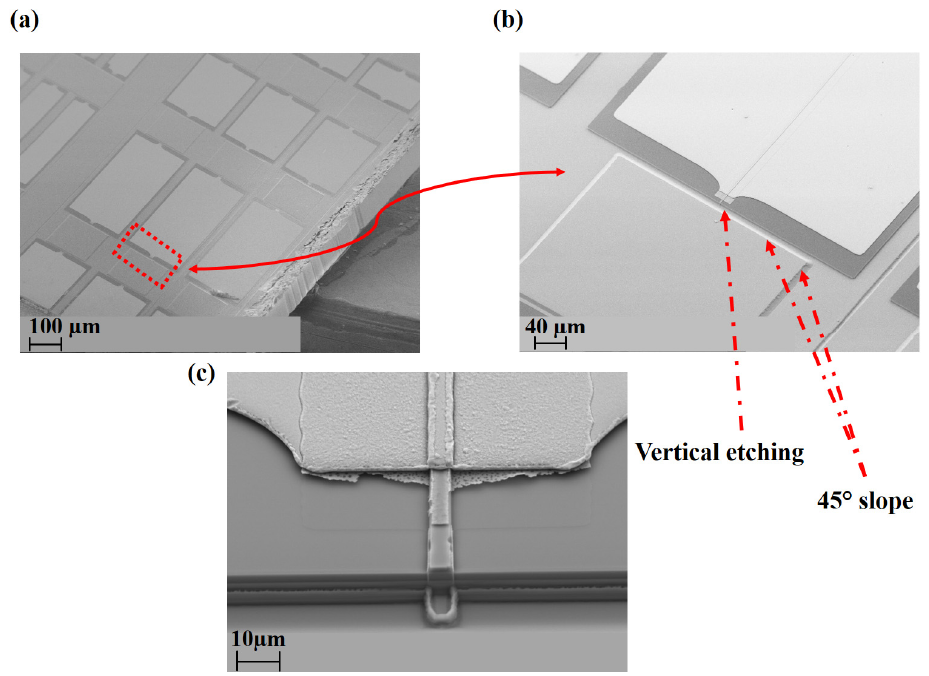
Figure 7. ( a ) SEM images of the fully processed 2D arrays ( b ) enlarged SEM image of an individual emitter with 45° inclined planes ( c ) zoomed in SEM image of the etched vertical laser facet of an individual emitter with horizontal lasing cavity from the top.